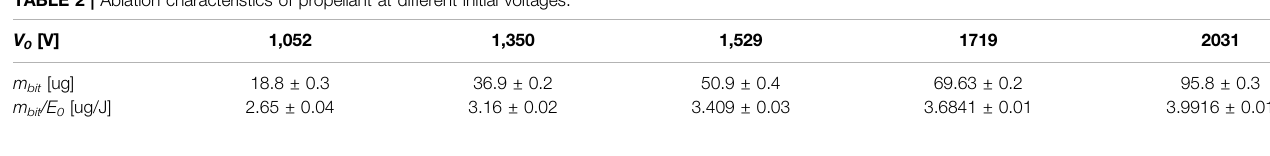
TABLE 2 | Ablation characteristics of propellant at different initial